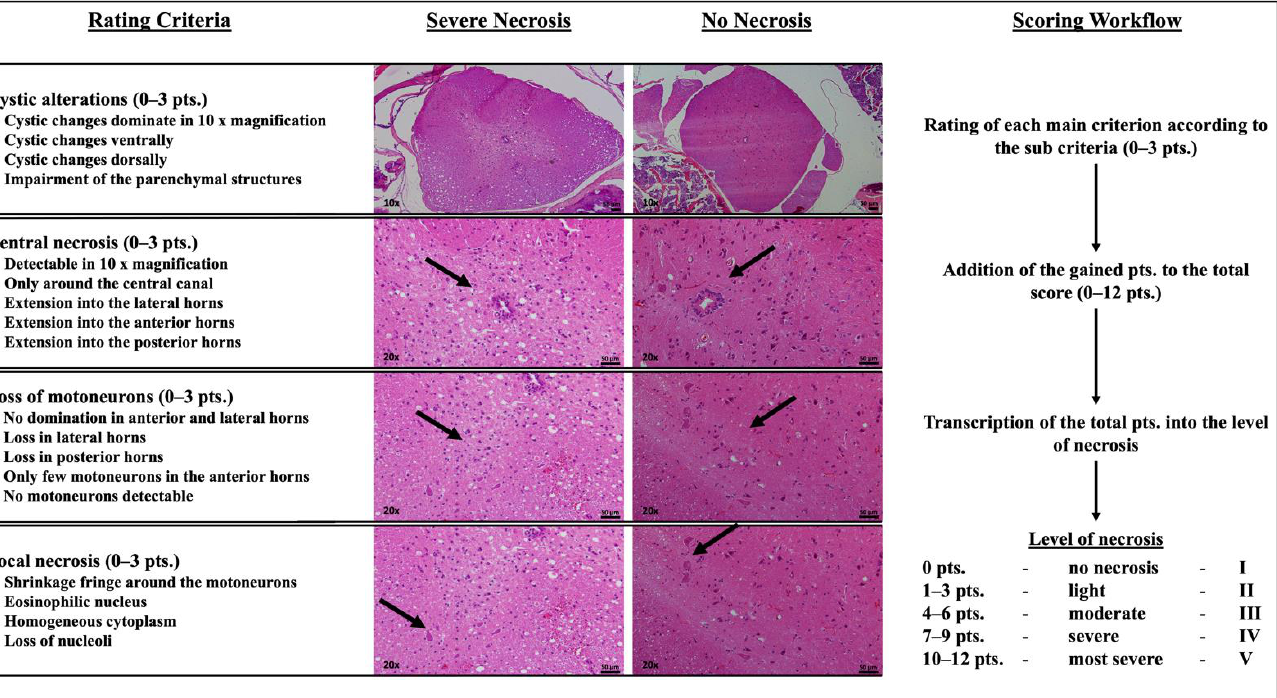
Figure 4. Workflow of the hematoxylin eosin necrosis score. This figure shows the workflow for evaluating the extent of necrosis in murine spinal cord based on hematoxylin eosin staining using a semiquantitative scoring system. There were four main criteria that were defined for the evaluation of necrosis. The arrows indicate the respective region or structure of interest for the evaluation of the main criterion. Each of these criteria was evaluated semi-quantitatively, according to sub-criteria, with 0 – 3 points (pts.). This results in a possible total score of 0 – 12 pts. This total score is translated into levels of necrosis (LON) from I – V as shown in the figure.